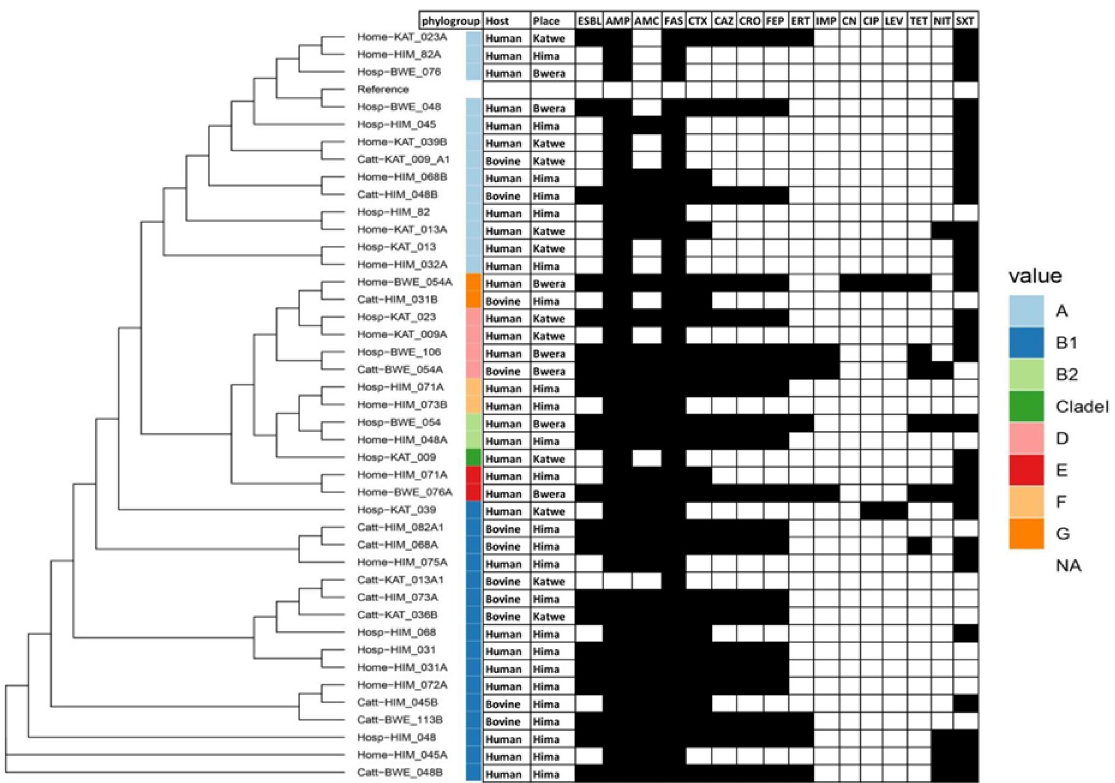
Fig 1. Maximum likelihood phylogenetic trees based on SNP differences within the core genomes and antibiotic susceptibility of E . coli isolated from humans and animals in Kasese district. The black shading indicates resistance. ESBL = Extended Spectrum β -lactamase, AMP = ampicillin, AMC = amoxicillin/clavulanic acid, FAS = cefazolin, CTX = Cefotaxime, CAZ = ceftazidime, CRO = ceftriaxone, FEP = cefepime, ERT = ertapenem, IMP = imipenem, CN = gentamicin CIP = ciprofloxacin, LEV = levofloxacin, TET = tetracycline, NIT = nitrofurantoin, SXT =